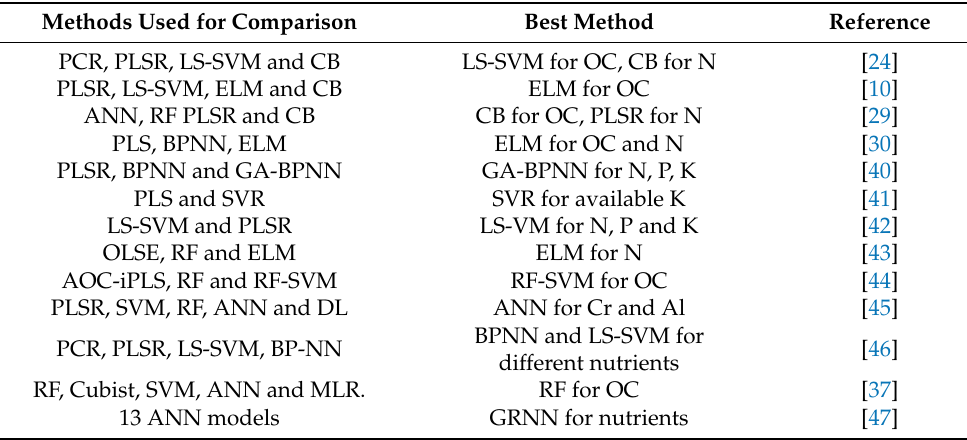
Table 1. Comparison of machine learning methods within VIS-NIR range. Methods Used for